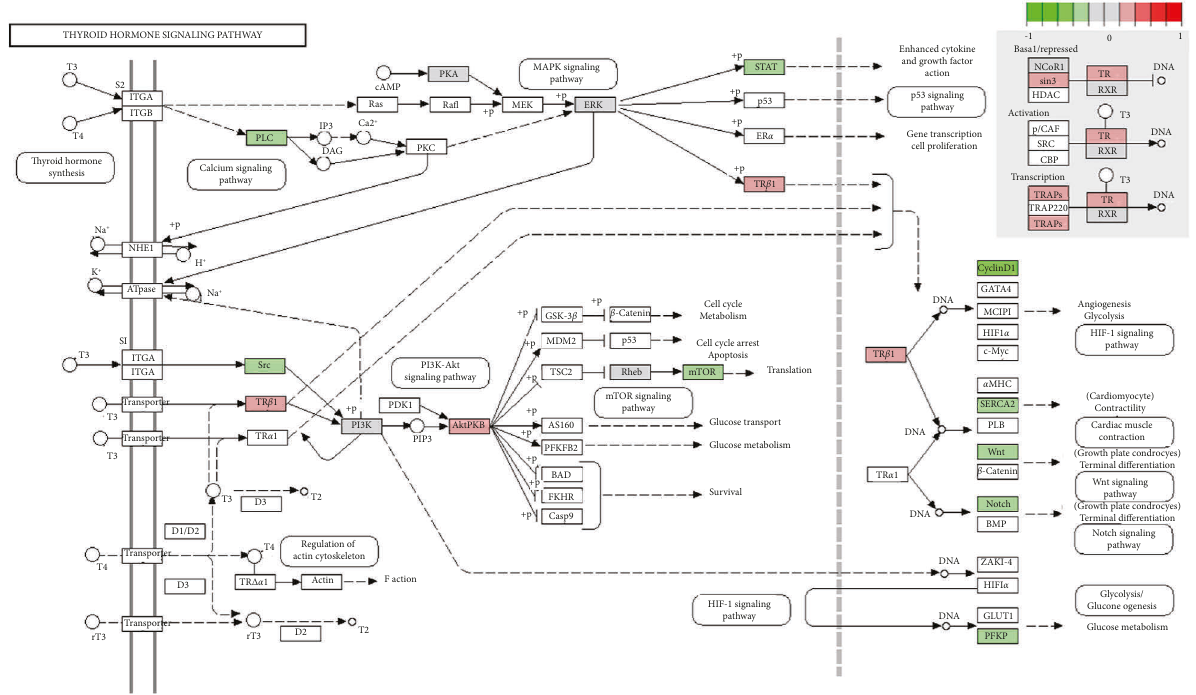
Figure 2: Changes in the expression of target genes of the thyroid hormone signaling pathway in patients with NAFLD. The changes are mapped with colors. The color depth positively correlated with the degree value. Red indicates increased expression, while green indicates decreased gene expression in the NAFLD group when compared with the healthy obese group.